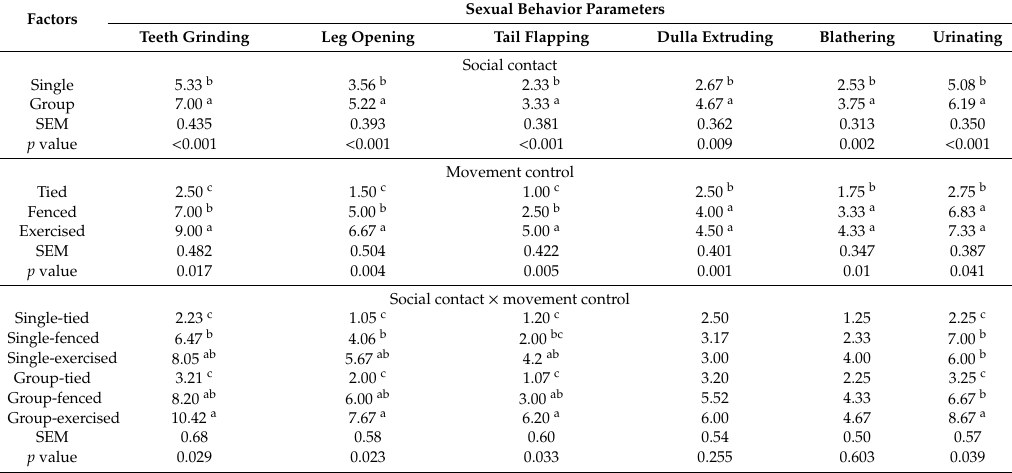
Table 3. E ff ects of social contact, movement control and their interaction on sexual behavior of male dromedaries during the rutting